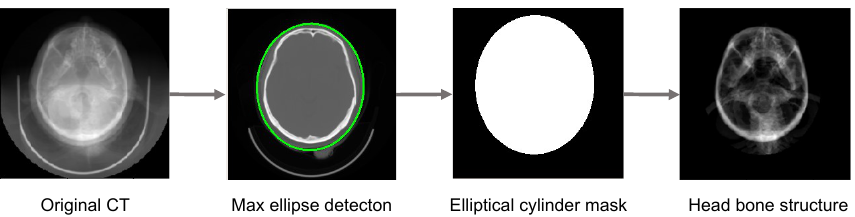
Figure 4. The workflow of the proposed preprocessing tool. The elliptical mask is 20% greater than the max detected